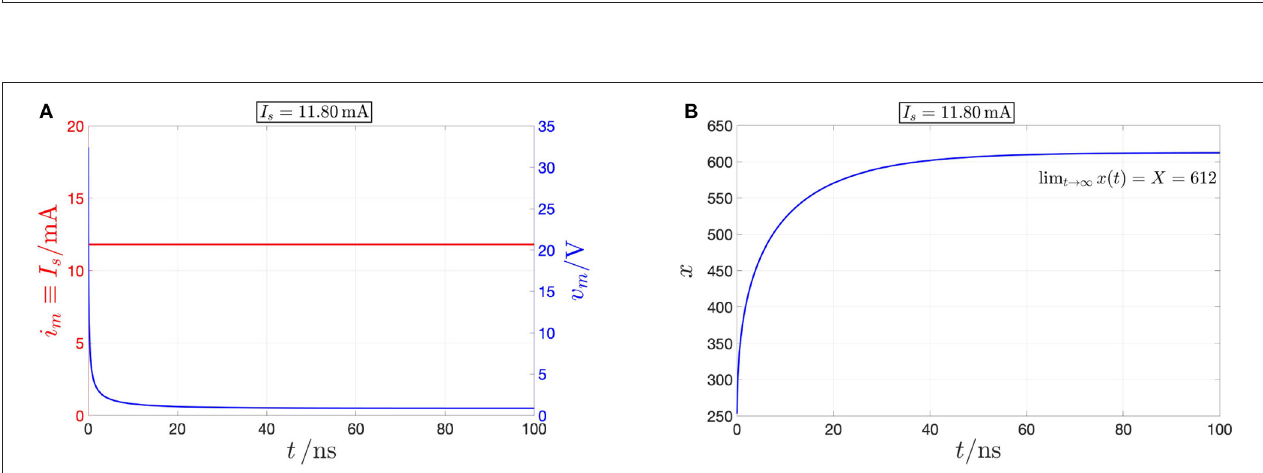
267 as t tends to . (C) Dash-dotted (solid) blue = ∞ 0.875V (red) and for an initial condition x 0 smaller (larger) than the unstable = 289 and X r 1456 = = 289 ( X r 1,456) as t tends to , for x 0 < ( > ) X 612. = = ∞ =